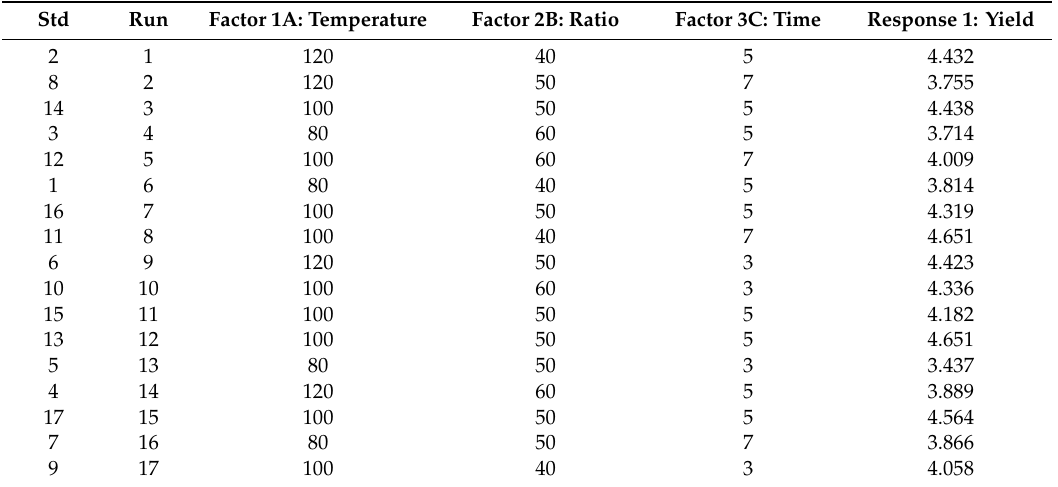
Table 2. Experimental results for the response variables, temperature, ratio, and